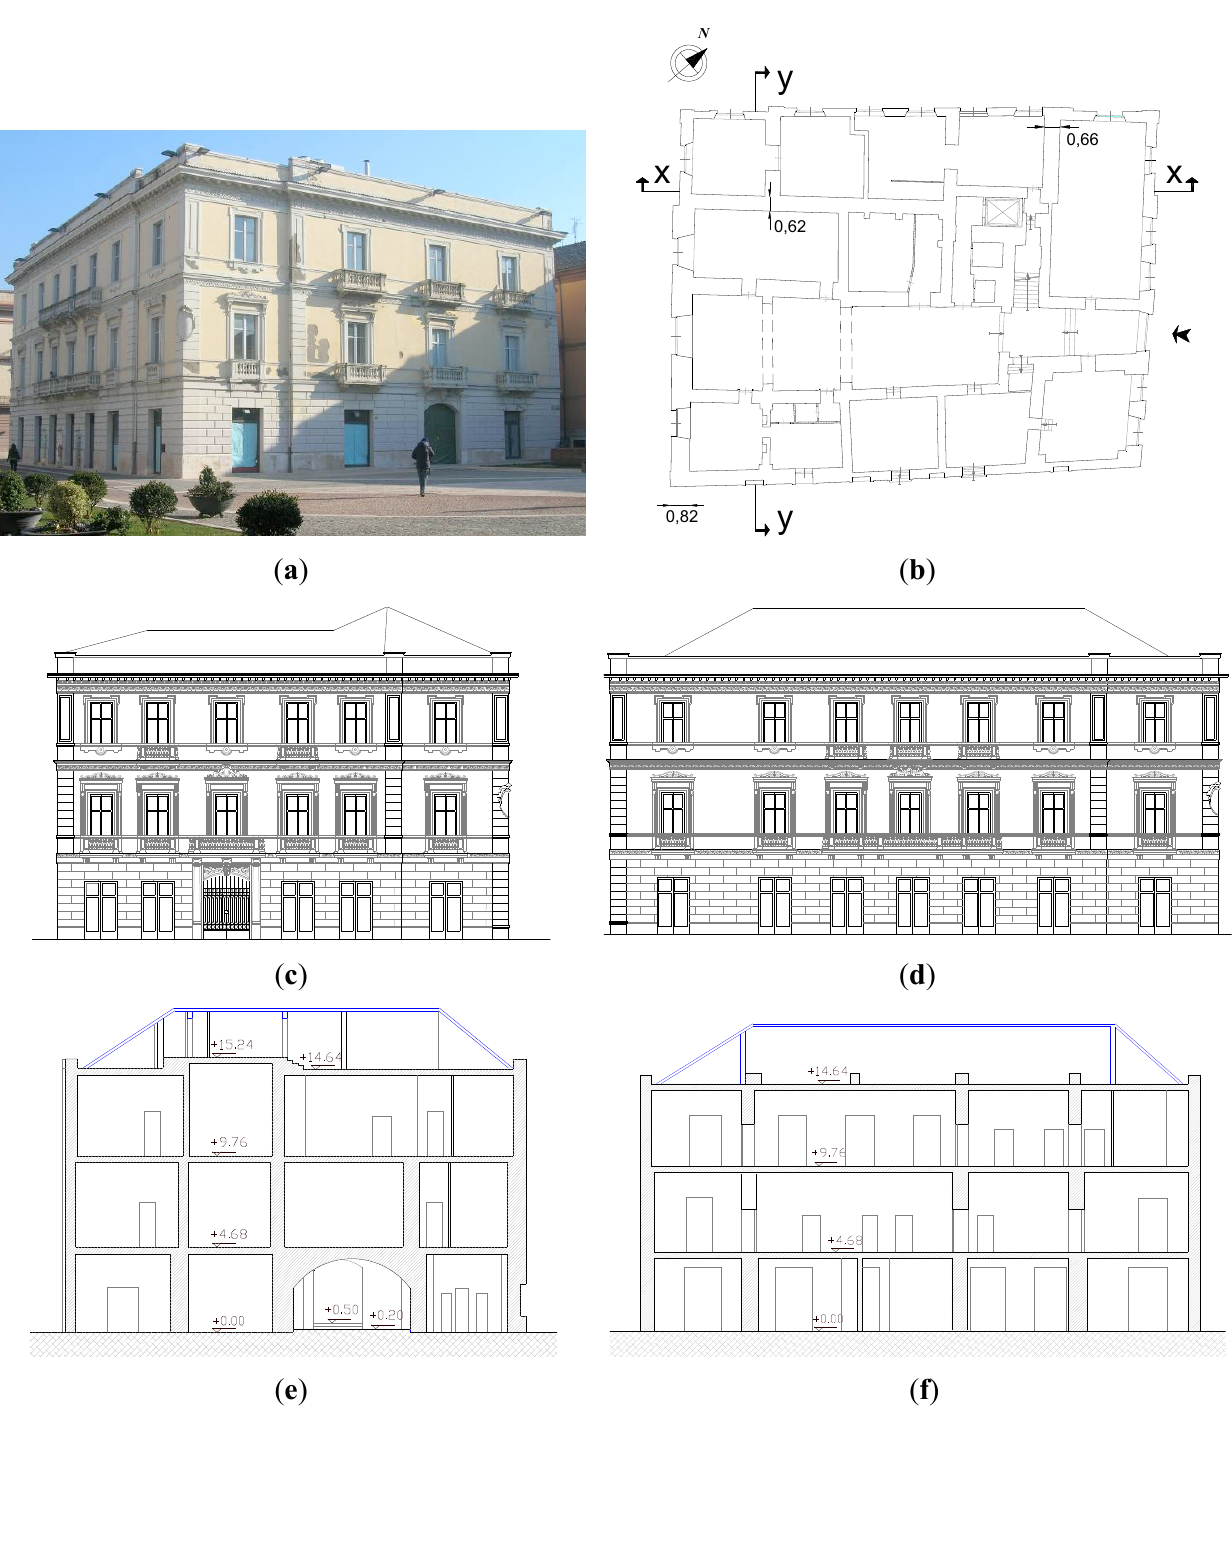
Figure 2. Palazzo Bosco Lucarelli: (a) Current photo of the Northwest and Southwest wings of the building; (b) plan of the ground floor; (c) survey of the Northeast façade (main entrance); (d) survey of the Northwest façade; (e) longitudinal section Y-Y; (f) longitudinal section